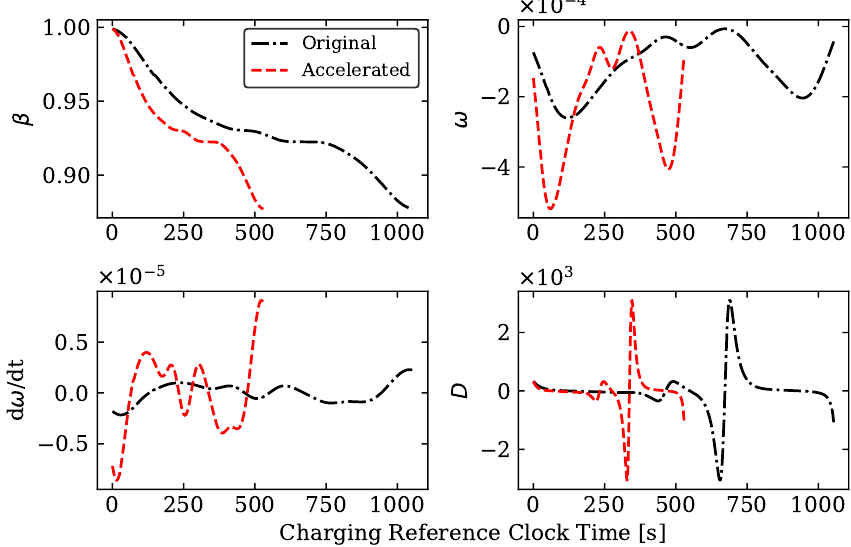
Figure 7. Scaling comparison of discharging mode at the centerline, phase